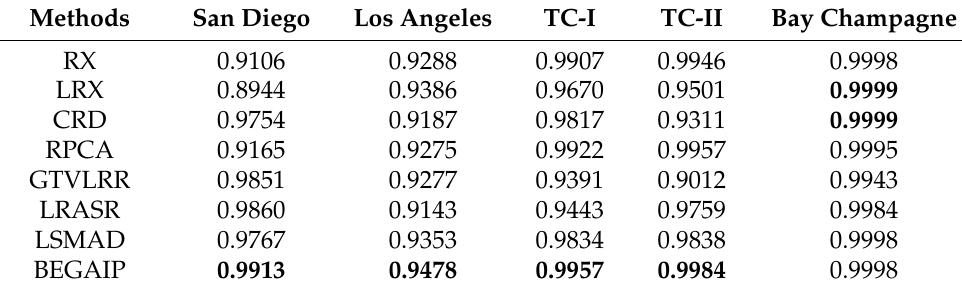
Table 1. AUC values of several methods on the four data